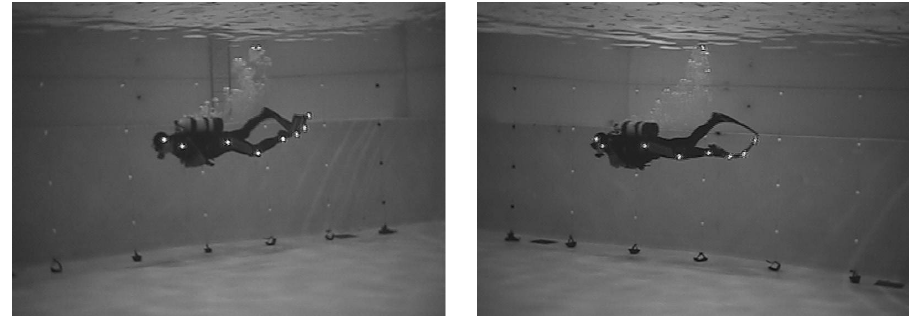
Figure 4. Images filmed by the two underwater cameras.